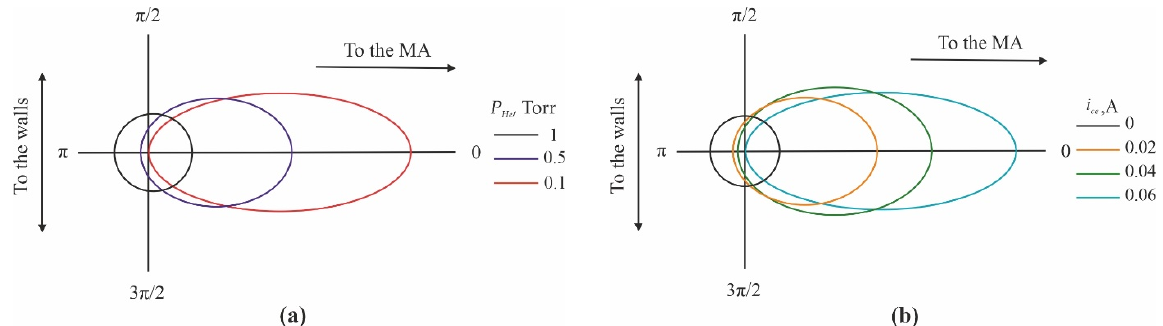
Figure 4. Angular structure of thermal electrons’ velocity distribution function near the anode hole: ( a ) For different values of helium pressure; ( b ) For various currents at the CE i ce and fixed pressure P He = 0.5 Torr. The horizontal axis coincides with the discharge symmetry axis.